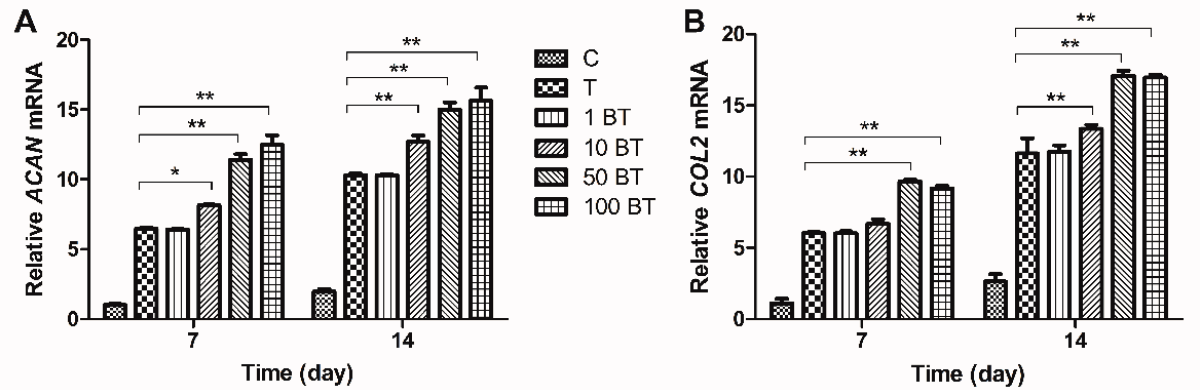
Figure 3. Relative gene expressions of MSCs on days 7 and 14. 10 ng/mL TGF- β , 1, 10, 50 and 100 ng/mL BMP3 were designed to clarify the effect of BMP3 alone on the expression of functional gene markers. Expression of ( A ) ACAN ; ( B ) COL2A1 ; ( C ) SOX9 and ( D ) COL1A1 was normalized to 18S and to the day 7 control group. Data represent mean ± SD; * p < 0.05, ** p <